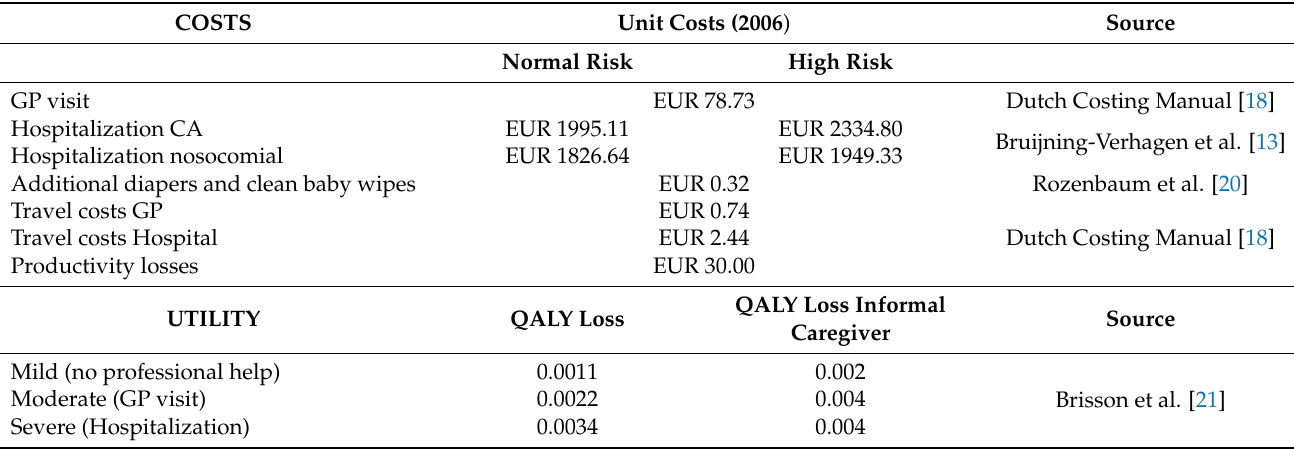
Table 3. Dutch unit costs (EUR) and utilities